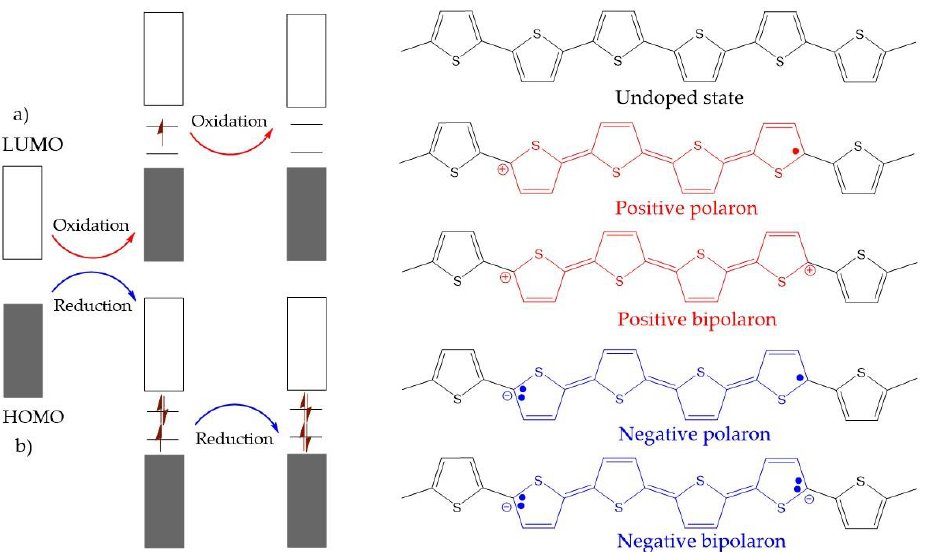
Figure 2. The electronic band and chemical structures of polythiophene (PT) with ( a ) p -type doping and ( b ) n -type doping.